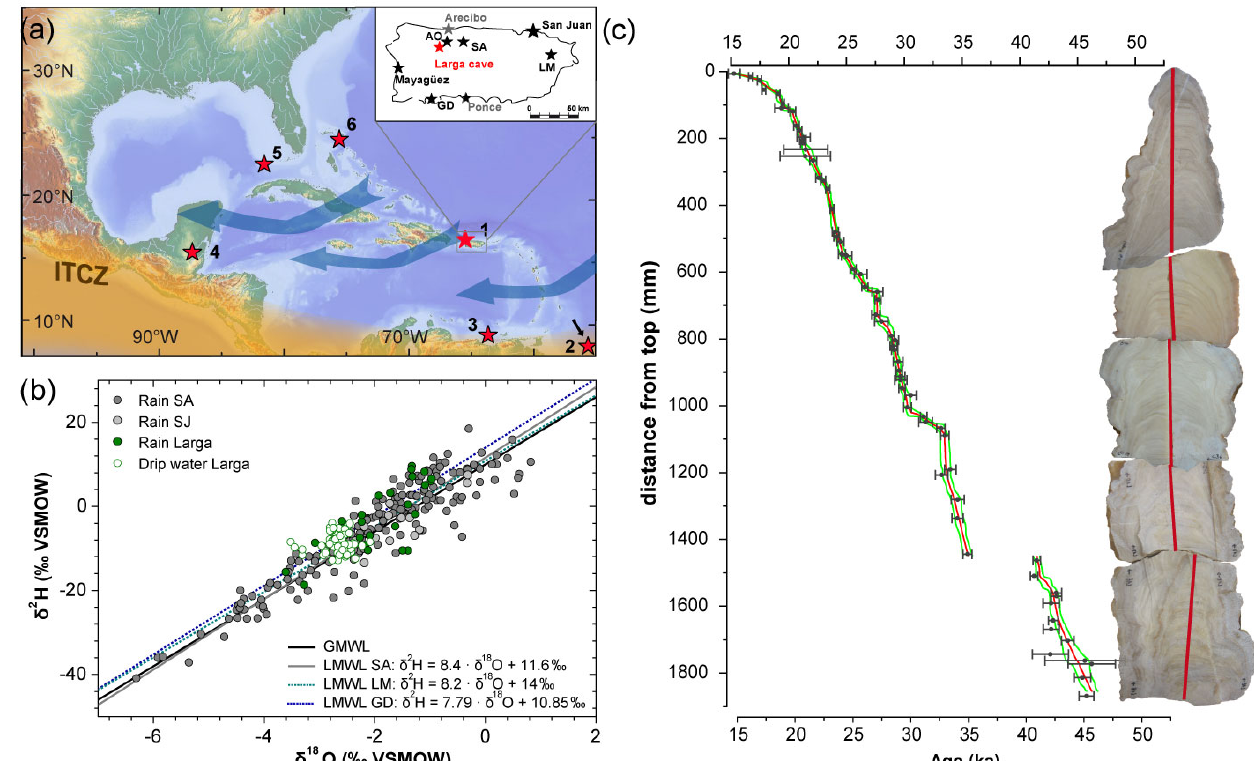
Figure 1. Sample locations and previous work on stalagmite PR-LA-1. (a) Location of Larga Cave (1), Puerto Rico, in the western tropical Atlantic region and other sites discussed in this study (map after Warken et al., 2020): (2) Guiana Basin (Rama-Corredor et al., 2015); (3) Cariaco Basin, Venezuela (Deplazes et al., 2013); (4) Lake Petén Itzá, Guatemala (Escobar et al., 2012; Grauel et al., 2016); (5) Florida Strait (Them Il et al., 2015); (6) Abaco, Bahamas (Arienzo et al., 2015). The insert shows a detailed view of the location of Larga Cave (red star), and the position of local meteorological stations: Arecibo Observatory (AO), San Agustín (SA), Luquillo Mountains (LM), and Guánica Dry Forest (GD). Blue arrows in panel (a) indicate the dominant moisture trajectories over the region in boreal summer, when the ITCZ (yellow shaded area) is in its northernmost position. (b) Local rainwater isotope data from Larga Cave (Vieten et al., 2018b), SA (Scholl et al., 2014) and Global Network of Isotopes in Precipitation (GNIP) station San Juan (SJ). In addition, the global meteoric water line (GMWL) and local meteoric water line (LMWLs) are shown from SA (Putman et al., 2019; Scholl et al., 2014); LM (Scholl and Murphy, 2014) and GD (Govender et al., 2013). (c) Image of stalagmite PR-LA-1 and age–depth model from Warken et al.